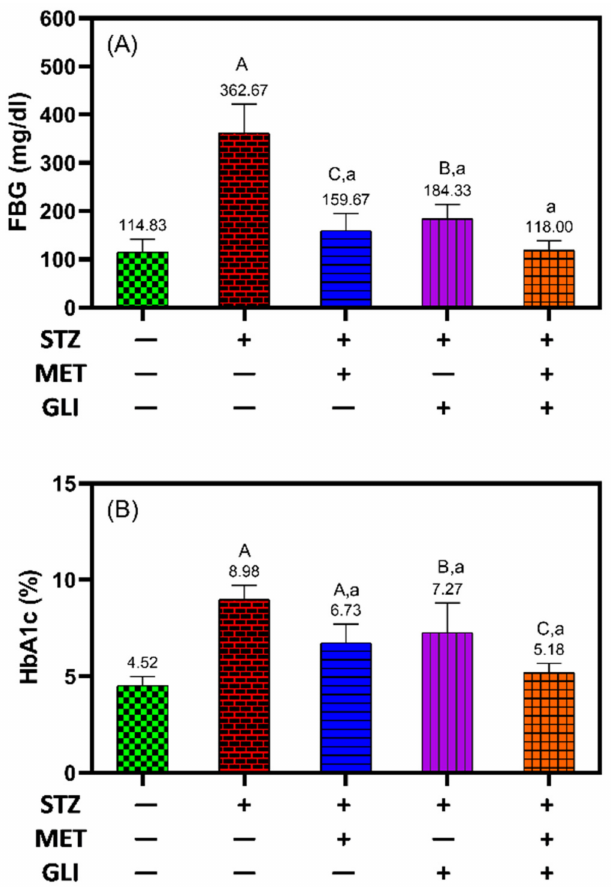
Figure 1. Effects of metformin, glipizide and their combination on ( A ) fasting blood glucose levels (FBG) and ( B ) glycated hemoglobin (HbA1c) levels in diabetic rats. The data is expressed as the Mean ± SD. A, B, and C notation (in capital letters) indicate the significant difference levels p < 0.001, p < 0.01, and p < 0.05 between studied groups and healthy controls, respectively. While a, b and c notation (in small letters) indicate the significant difference levels p < 0.001, p < 0.01, and p < 0.05 between studied groups and untreated DM groups,